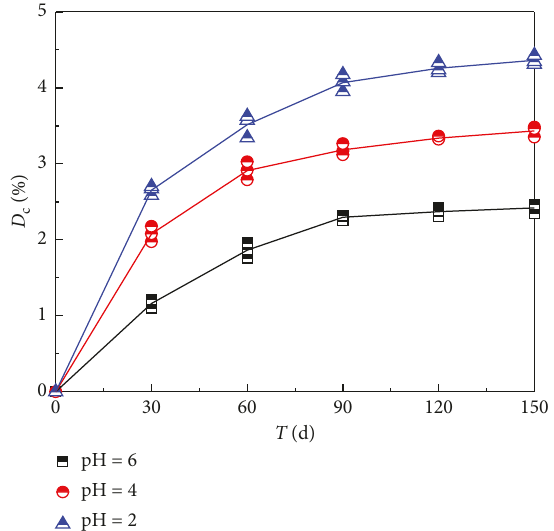
Figure 5: Variation in damage variable versus corrosion